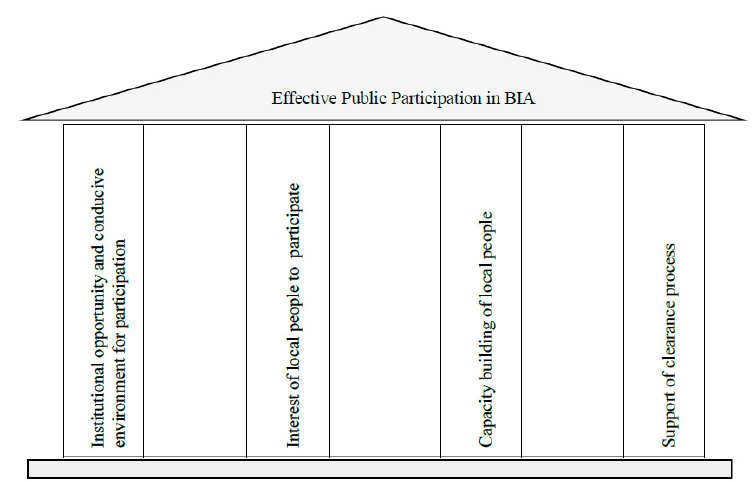
Figure 5. Four pillars of effective public participation in EIA.